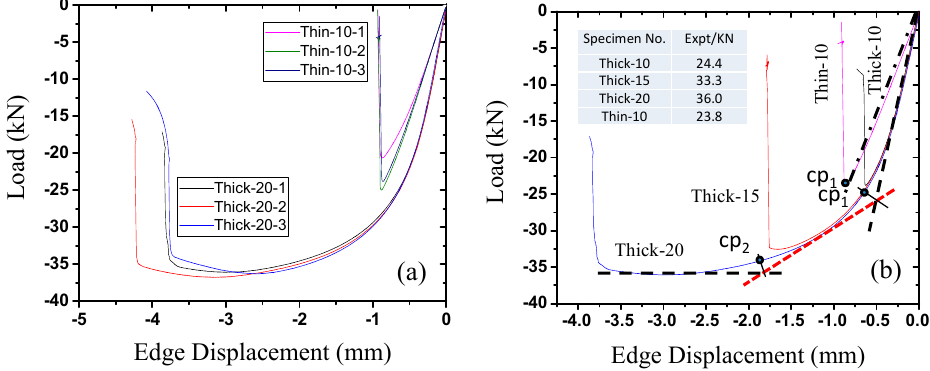
Figure 4. Load–displacement curves of lateral compression test pieces: ( a ) divergence of the internal components of the “thick type” and “thin type”; ( b ) overall results of the test pieces.